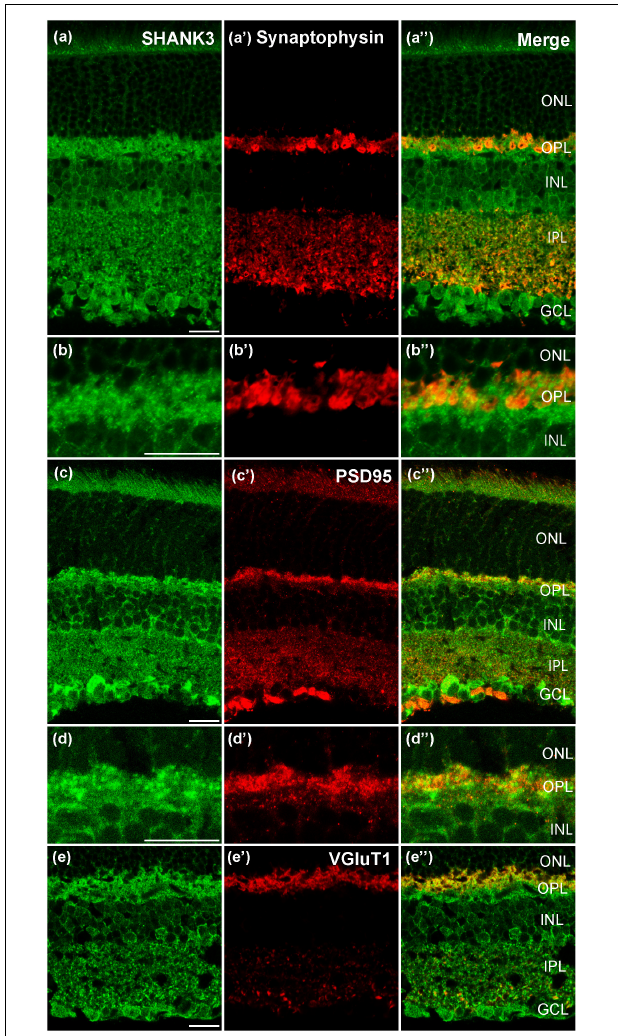
FIGURE 5 | Confocal microphotographs showing the distribution of SHANK3 in synaptic. Double staining (green for SHANK3; red for Synaptophysin, PSD95 and VGluT1) appear yellowish. (a–a”) Colocalization of SHANK3 with Synaptophysin in a retinal vertical section. Fluorescence double stainings show that SHANK3 (a) and the Synaptophysin (a’,a”) is the merged image of Synaptophysin and SHANK3. (b–b”) are the locally magnified images for (a–a”) . The merged image shows that the presynaptic membrane is not labeled by SHANK3. (c–c”) Colocalization of SHANK3 with PSD95 in a retinal vertical section. Fluorescence double stainings show that SHANK3 (c) and the PSD95 (c’,c”) is the merged image of PSD95 and SHANK3. (d–d”) are the locally magnified images for (c–c”) . The merged image shows that the postsynaptic membrane is SHANK3-positive. (e–e”) Colocalization of SHANK3 with VGluT1 in a retinal vertical section. Fluorescence double stainings show that SHANK3 (e) and the VGluT1 (e’,e”) is the merged image of VGluT1 and SHANK3. Scale bar = 20 µ